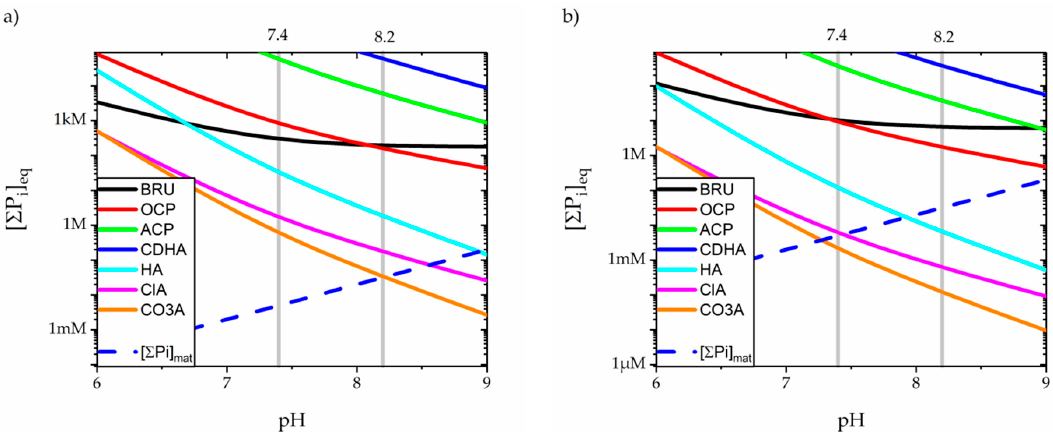
(cid:80) Figure 4. The calculated equilibrium concentrations [ P i ] eq required for the formation of calcium Figure 4. The calculated equilibrium concentrations [ ∑ P i ] eq required for the formation of calcium phosphates as functions of pH. Calcium concentration set to ( a ) [Ca 2 + ] = 0.17 µ M and ( b ) [Ca 2 + ] = 5 µ phosphates as functions of pH. Calcium concentration set to ( a ) [Ca 2+ ] = 0.17 μ M and ( b ) [Ca 2+ ] = 5 μ M.